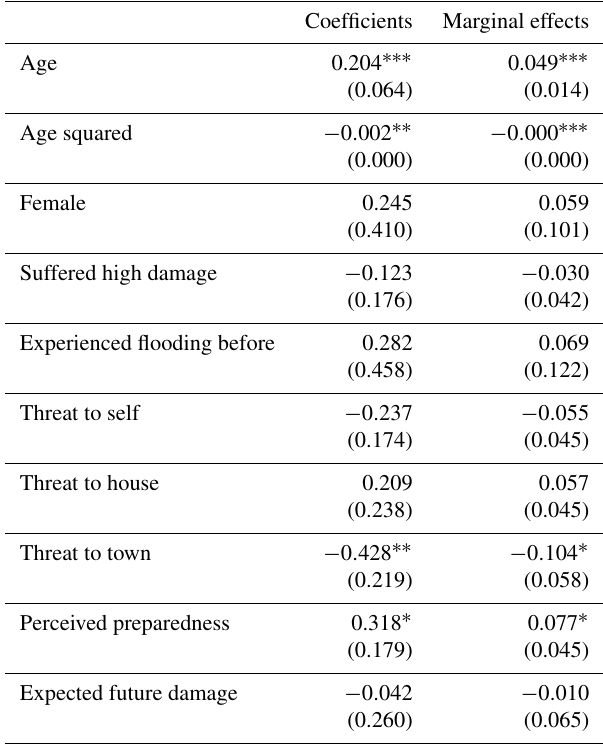
Table 4. Logit regression model of the probability of a respondent moving from round 1 to round